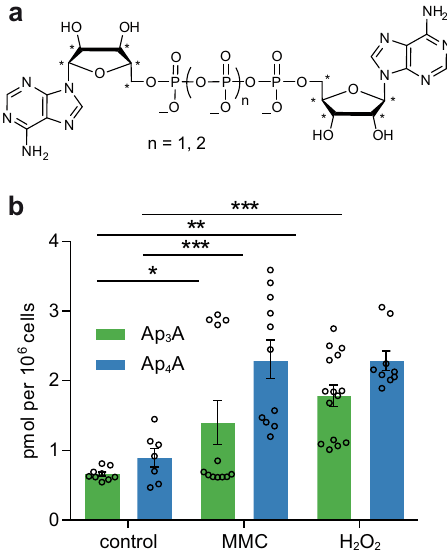
Fig. 2 Determination of Ap 3 A and Ap 4 A levels in HEK293T cell lysates. a Chemical structures of 13 C-labeled 13 C 10 -Ap 3 A ( n = 1) and 13 C 10 -Ap 4 A ( n = 2) used as internal standards. b Obtained Ap 3 A (green) and Ap 4 A (blue) levels of stressed and unstressed (control) HEK293T cells. For each condition 15 biological replicates were performed. Samples were measured in technical duplicates and averaged. Measurements with a signal to noise ratio below 7 were excluded. Data presented are mean ± standard error of the mean (SEM); n (control, Ap 3 A) = 9, n (control, Ap 4 A) = 7, n (MMC, Ap 3 A) = 12, n (MMC, Ap 4 A) = 11, n (H 2 O 2 , Ap 3 A) = 15, n (H 2 O 2 , Ap 4 A) = 9. Signi fi cant differences were determined by one-way ANOVA in combination with the Dunnett test (* p ≤ 0.05; ** p ≤ 0.01; *** p ≤ 0.001). Source data are provided as a Source Data fi